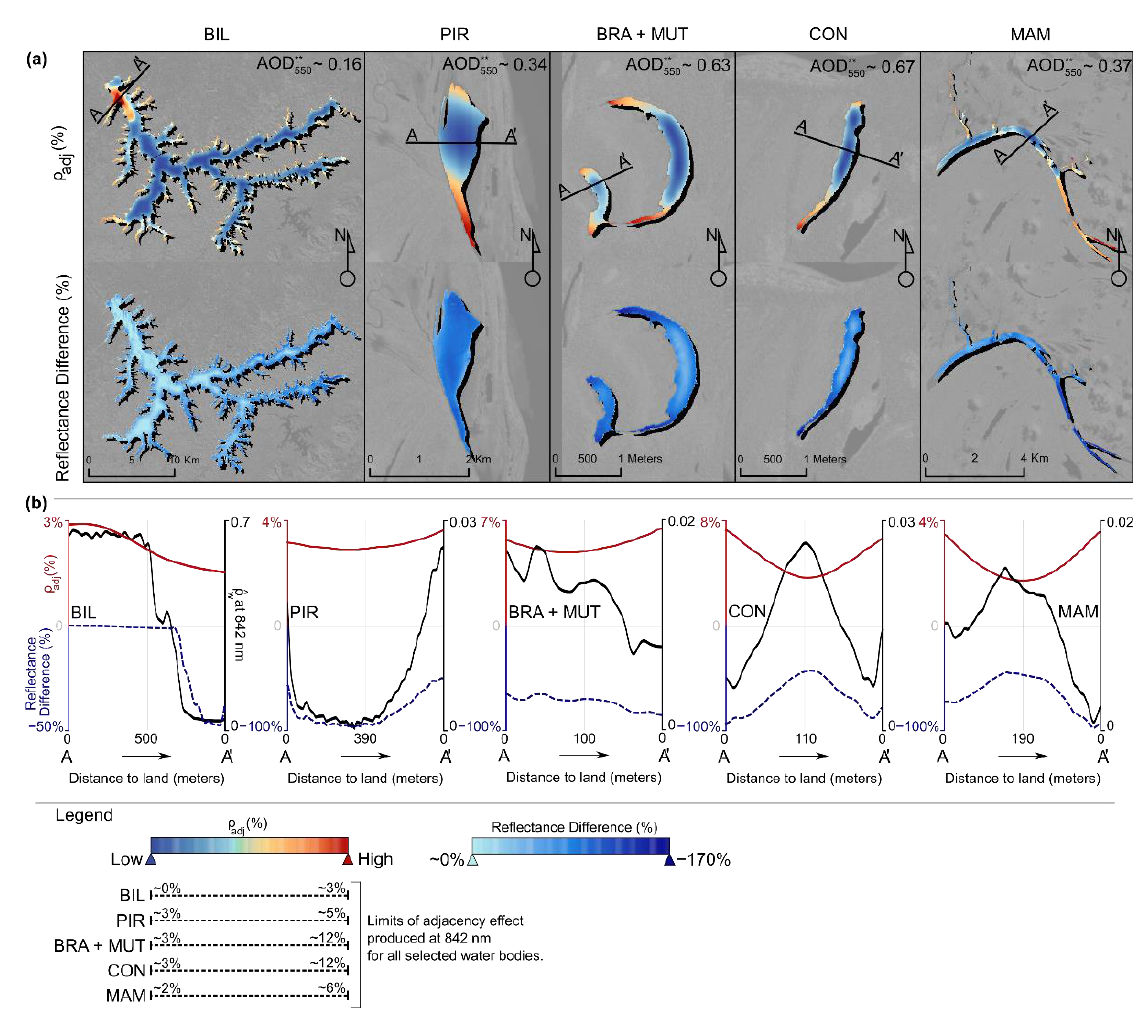
Figure 10. ( a ) Spatial distribution of the ρ adj (in %) and MSI-derived water reflectance difference (in %) before and after adjacency correction at 842 nm. ( b ) The transect of ρ adj (%), reflectance difference (%), and water reflectance in the A → A (cid:48) setting along the water body. In ( a ), the ρ adj was obtained by multiplying the average reflectance of the environment and the ratio between the diffuse atmosphere transmission by the total (upward) ( ρ adj ( B /T ↑ ) (see Equation (4) in [62]). B i refers to the MSI band at 842 nm. Here, the H Adj was defined using the fixed window approach (Figure 4). The reflectance difference was negative when the corrected water reflectance value was smaller than the uncorrected water reflectance value.